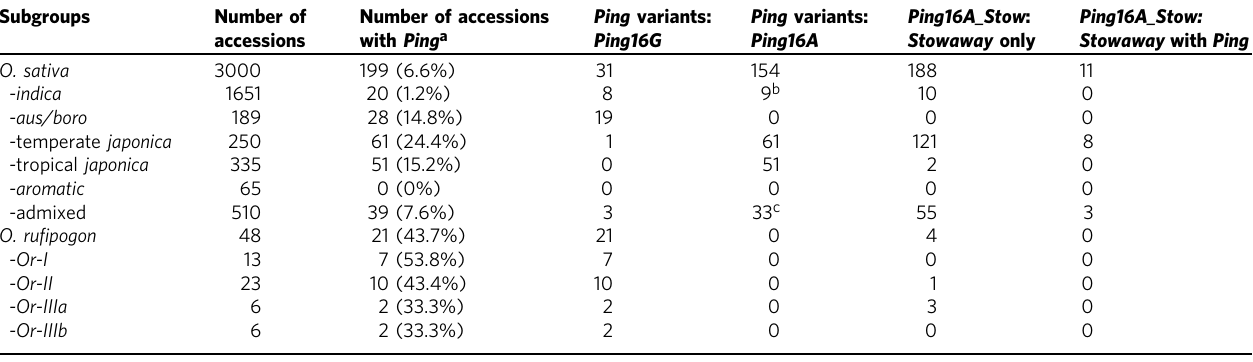
Table 1 Distribution of Ping variants and Ping16A_Stow genotypes in domesticated rice and O. ru fi pogon Subgroups Number of Number of accessions accessions with Ping a